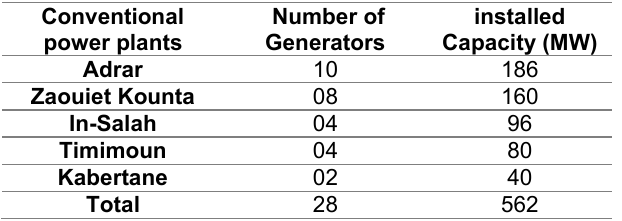
Table 7. Conventional power plants installed capacity for PIAT electrical grid.